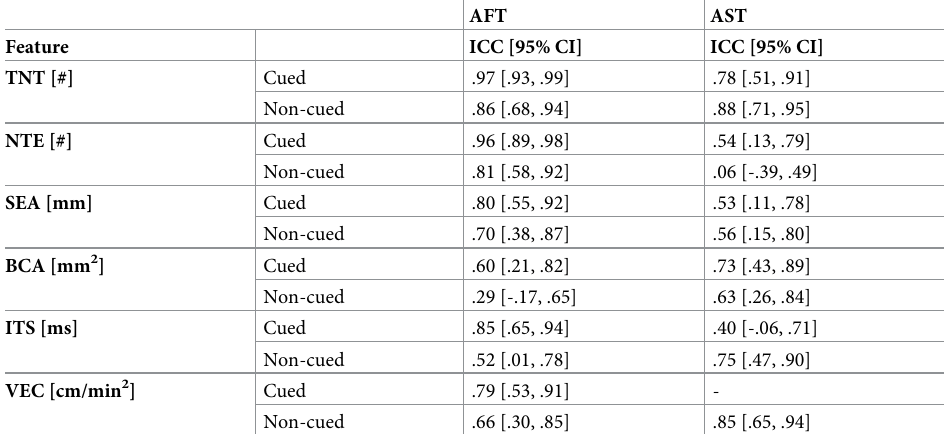
Table 4. Between-day repeatability.